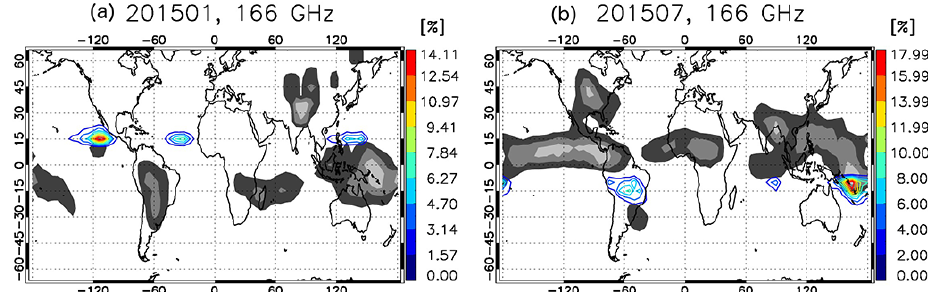
Figure B2. Geographical distribution (colored contours) of negative PD occurrence frequency during January (a) and July (b) 2015 for 166GHz. Gray shades marked the occurrence frequency of PD–TB V <160K scenes, which is essentially equivalent to the occurrence frequency of deep convections, except that the signal over the Tibetan Plateau in panel (a) is probably induced by surface